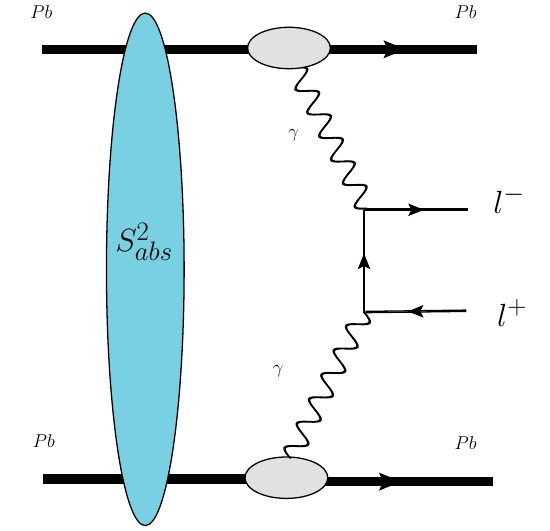
Fig. 1 Exclusive dilepton production by γγ interactions in ultrape- ripheral PbPb